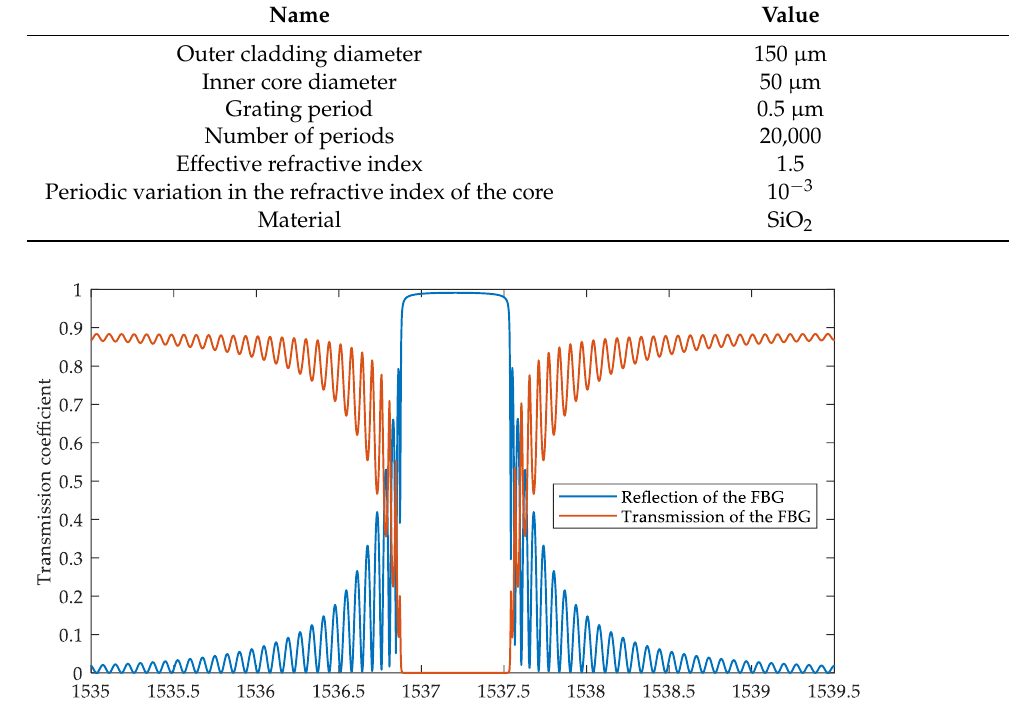
Figure 13. FBG transmission and reflection spectra at the resonant wavelength λ B = 1537.2 nm. The modeling has shown that the scheme using an OEO as a source cannot work properly with standard FBG due to the relatively wide FBG’s output spectrum. However, an OEO can be applied with appropriately designed fiber grating sensors, e.g., a narrow- band phase-shifting Bragg grating (PS-FBG).